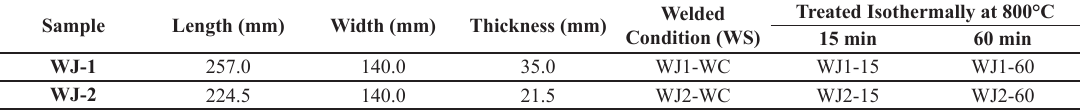
Table 1. Characteristics and samples identification.